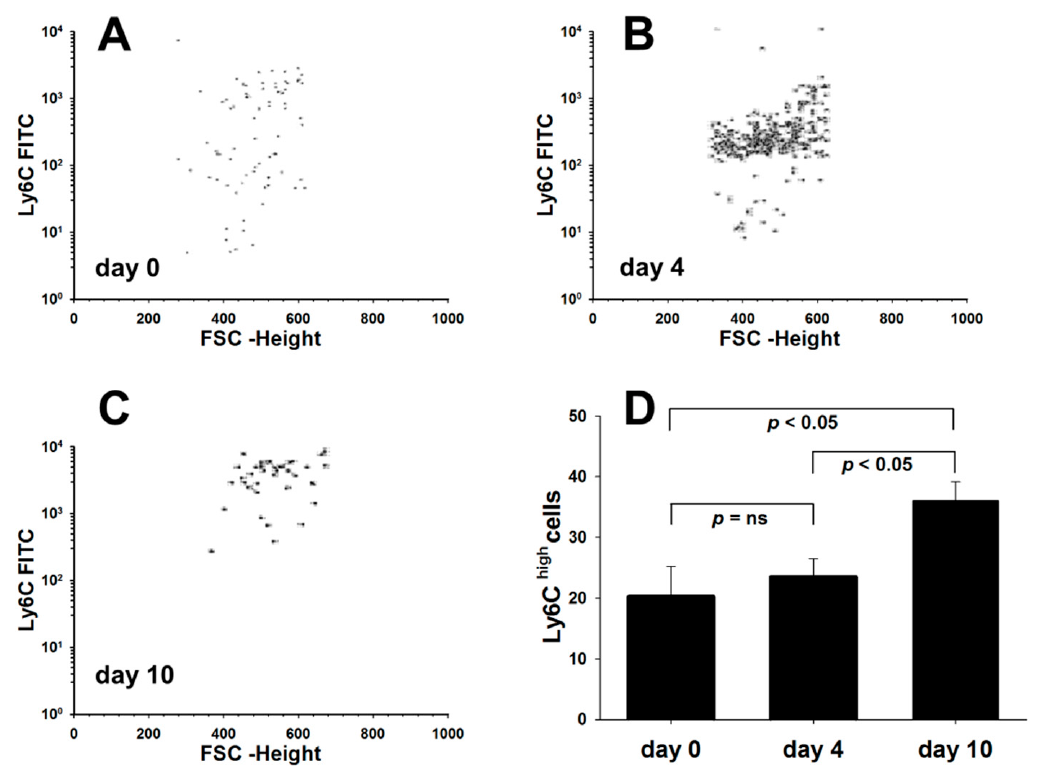
Figure 3. Inflammation induced changes in the expression of blood monocytes during the course of colitis. Murine peripheral blood monocytes were analyzed by flow cytometry for the expression of Ly-6C on CD11b-positive cells. Shown are data from one experiment (n = 5 per group), confirmed in two experiments. Fluorescence-activated cell sorting (FACS) dot plots of Ly6C expression on SSC low CD11b high cells of mice before ( A ; day 0), during ( B ; day 4), and after colitis induction ( C ; day 10). ( D ) The number of Ly6C hi monocytes circulating in mice prior (day 0) and after colitis induction (day 4 and 10) per 2 × 10 5 cells measured.